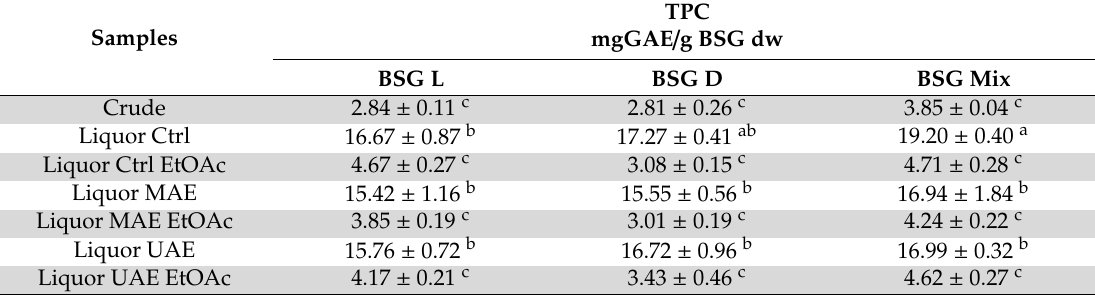
Table 1. Total phenolic contents in mg GAE / g BSG dw in the NaOH saponified BSG extracts (liquors) and their subsequent ethyl acetate fractions following neutralisation (EtOAc); Ctrl represents maceration method, microwave assisted extraction (MAE), ultrasound assisted extraction (UAE) of light (L), dark (D) and Mix BSG. For each substrate, total phenolic content (TPC) values bearing di ff erent letters (a, b, c) are significantly di ff erent ( p < 0.05) from each other. Shadow is to make the data distinguishable between the